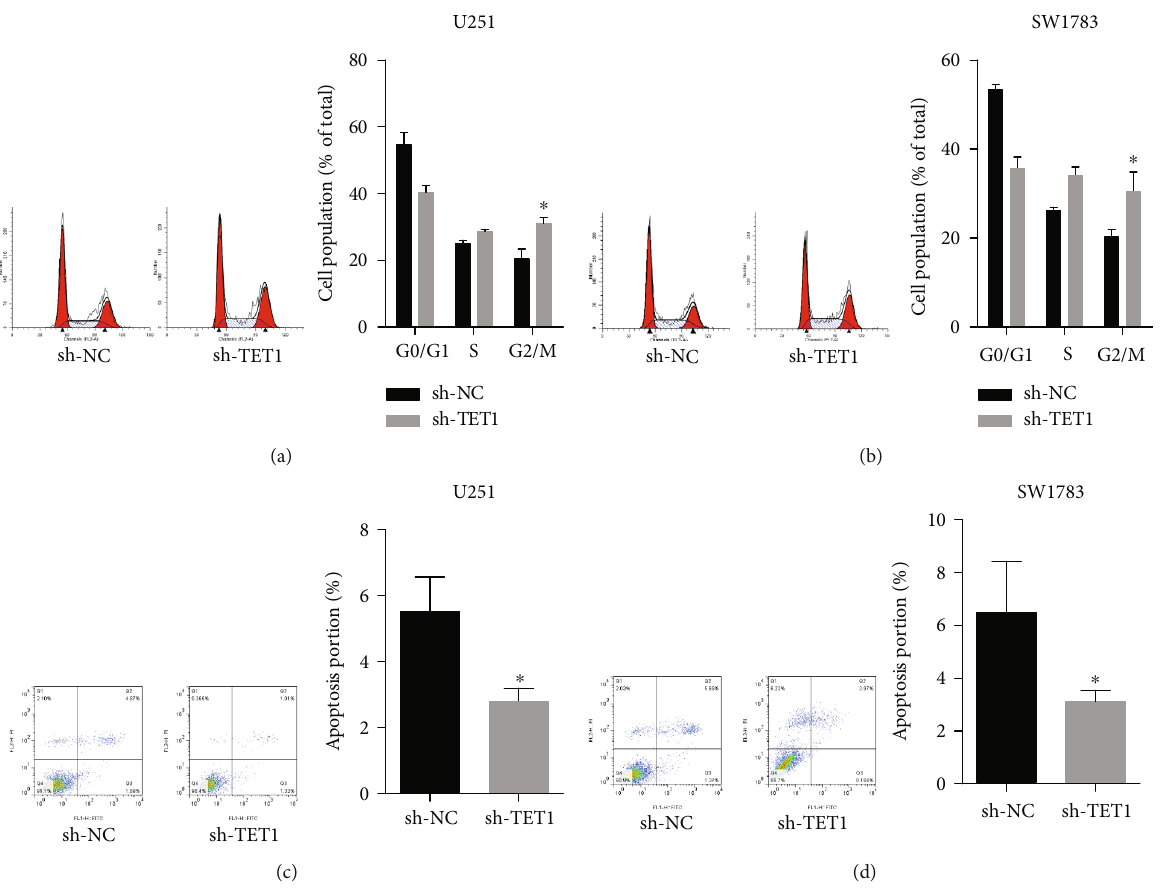
Figure 4: Downregulation of TET1 disrupted cell cycle distribution and inhibited apoptosis of U251 and SW1783 cells. (a, b) The cell cycle distributions of U251 and SW1783 cells were evaluated by fl ow cytometry. (c, d) The apoptosis rates of U251 and SW1783 cells were detected by fl ow cytometry. ∗ P < 0 : 05